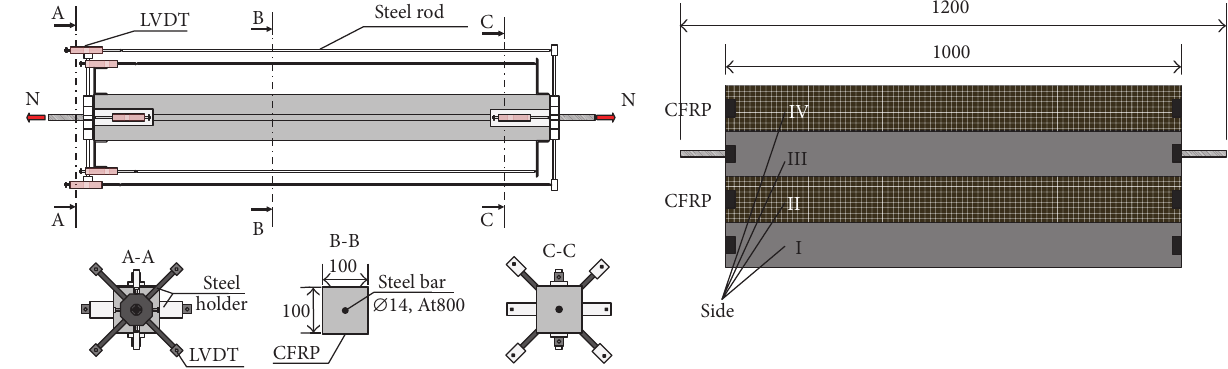
Figure 1: Tie test setup.